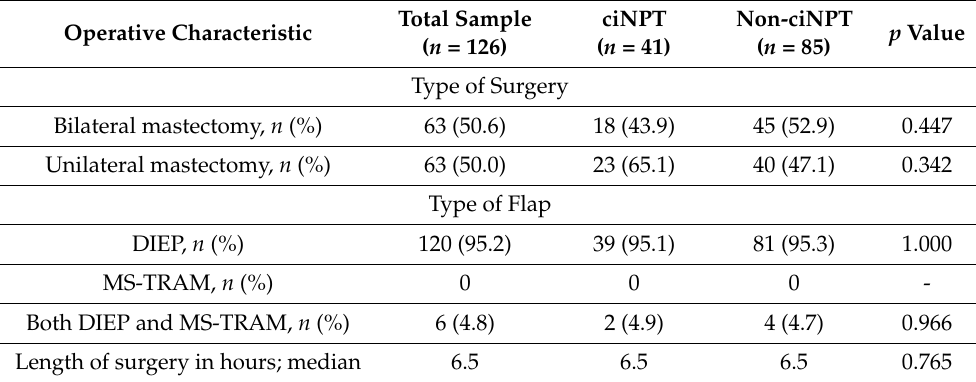
Table 2. Operative characteristics: ciNPT vs. non-ciNPT patients.